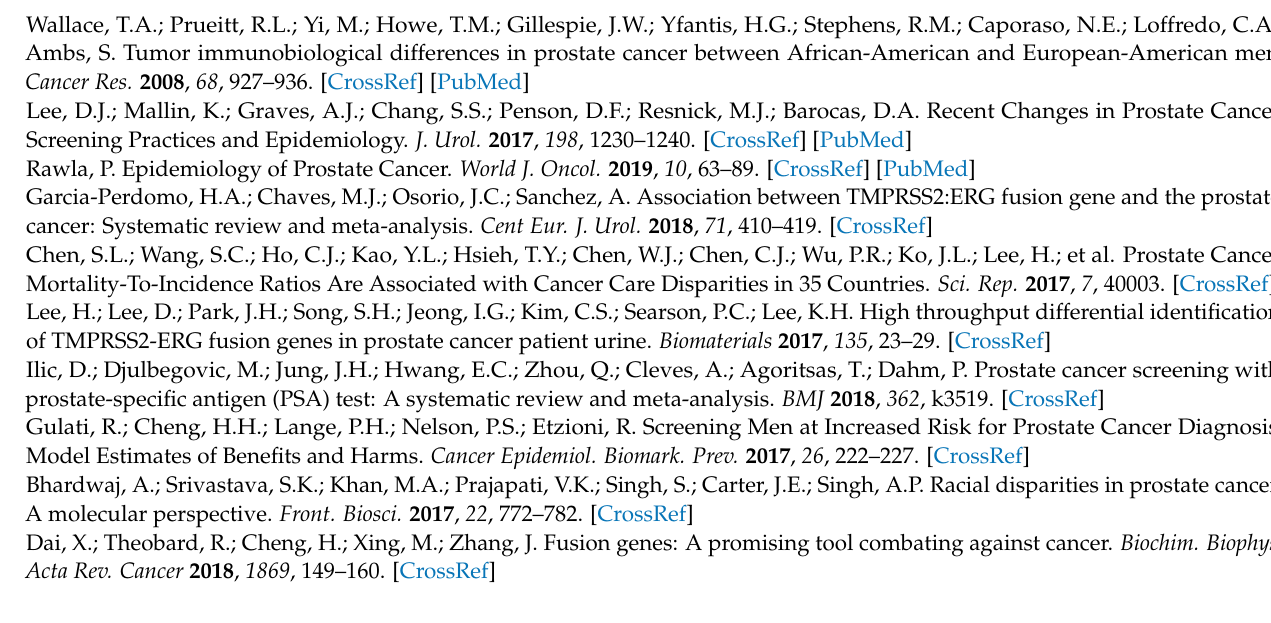
Table S1: Patients IDs, demographic and clinical information; Table S2: Summary of model cell lines; Table S3: Cell line results organized by tool; Table S4: Predicted fusions detected by each of the four programs, STAR-Fusion, FusionCatcher, JAFFA and ChimeraScan respectively; Table S5: Summary of predicted fusion genes; Table S6: Racial differences in predicted fusion genes in in African American and European American men; Table S7: Shared fusions across EA patients using the fusion prediction tools.; Table S8: Shared fusions across AA patients using the fusion prediction